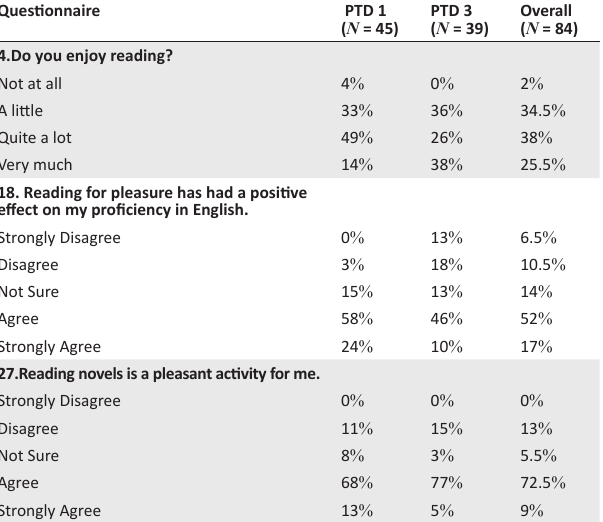
TABLE 2: Some questionnaire responses.